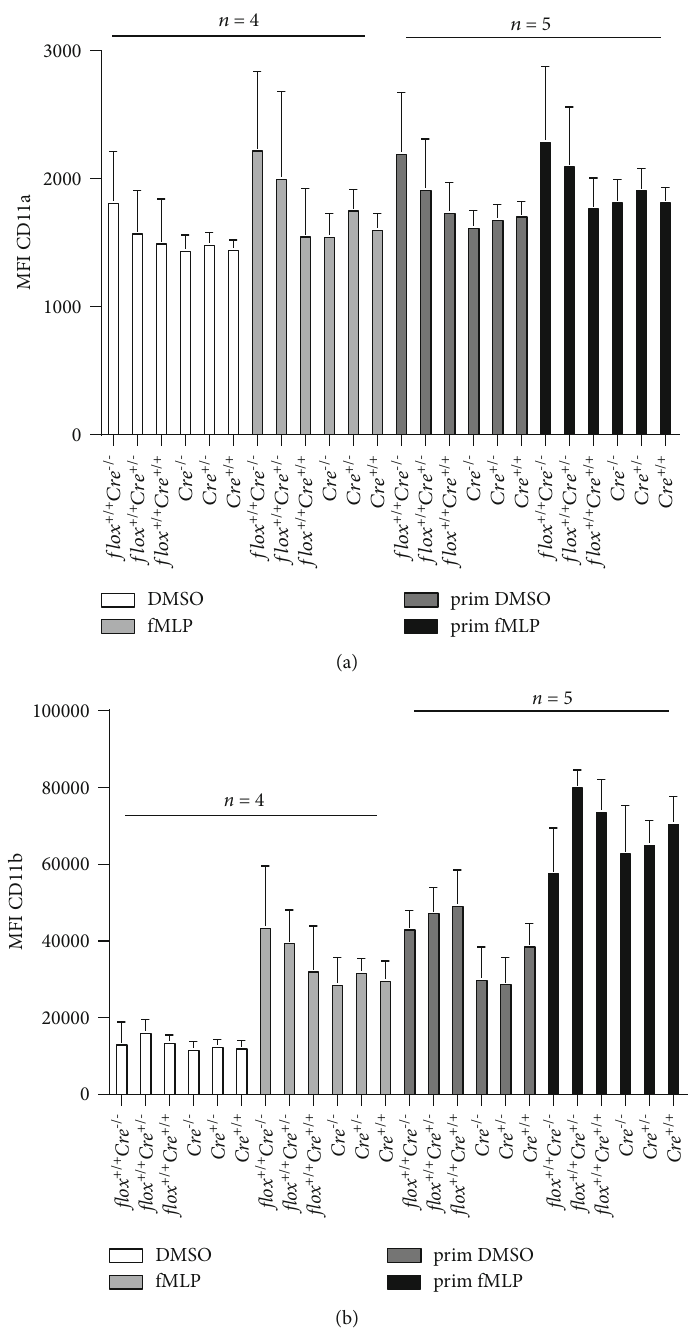
Figure 4: Cell surface exposure of CD11a and CD11b in control and stimulated BM PMNs. BM PMNs puri fi ed using a Percoll gradient and negative selection were treated without or with GM-CSF and TNF for 20min before stimulation with fMLP for 15 min. Ly6G + cells (PMNs) were gated to evaluate cell surface expression of CD11a (a) and CD11b (b) in all mouse strains ( n = 4 -5 independent experiments, 2 mice/genotype) (prim =GM-CSF and TNF